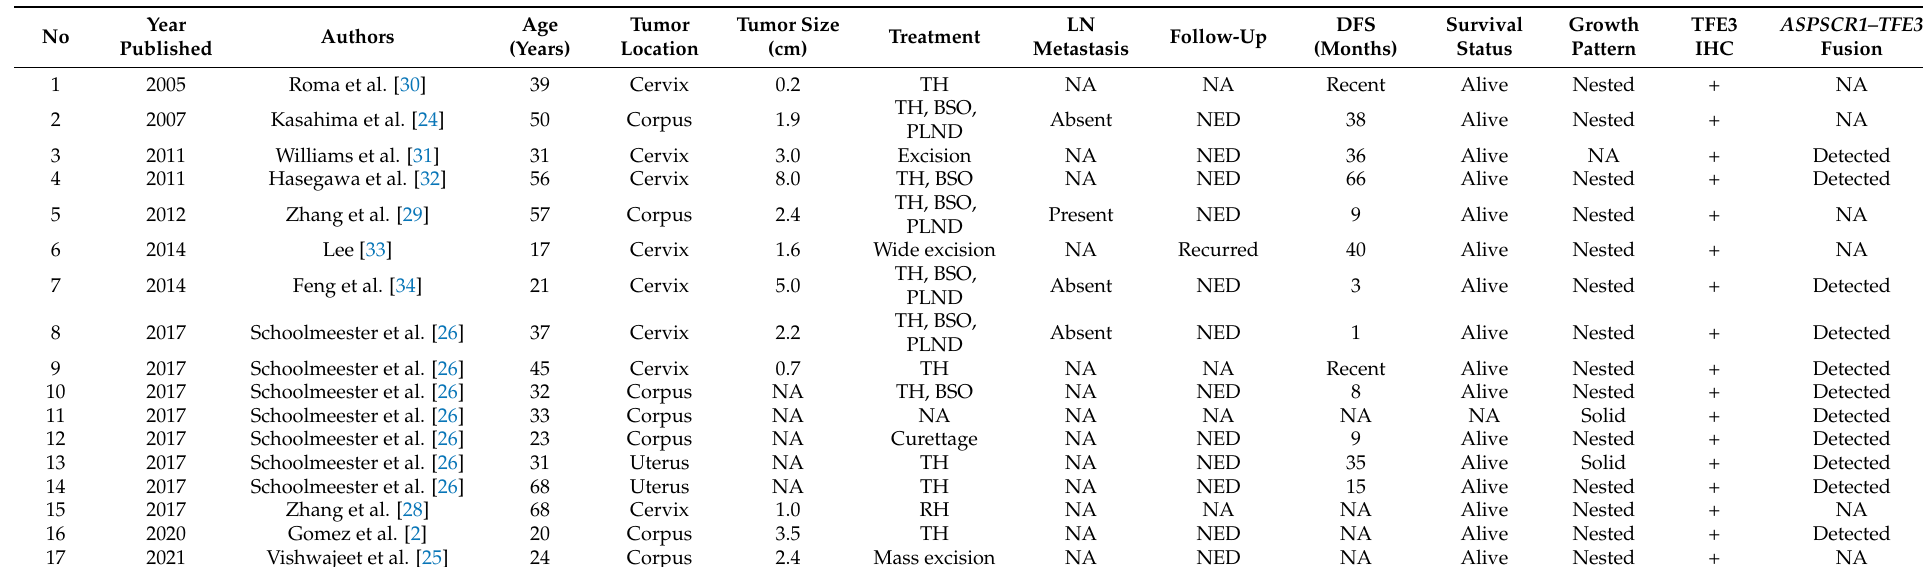
Table 3. Summary of previously published cases of primary uterine alveolar soft part